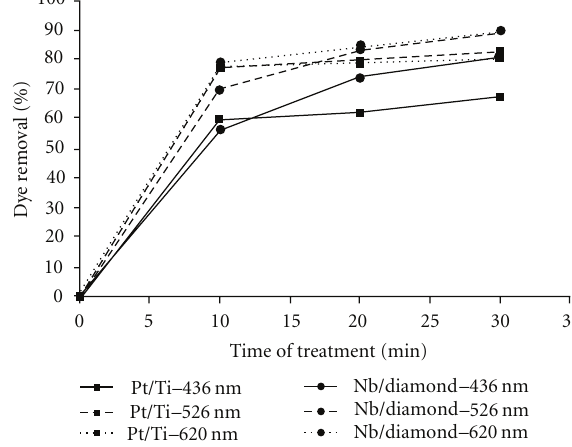
Figure 12: Decoloration e ffi ciency of Nb/D and Pt/Ti, treating real wastewater. Applied potential: 18V; time of treatment: 30 min